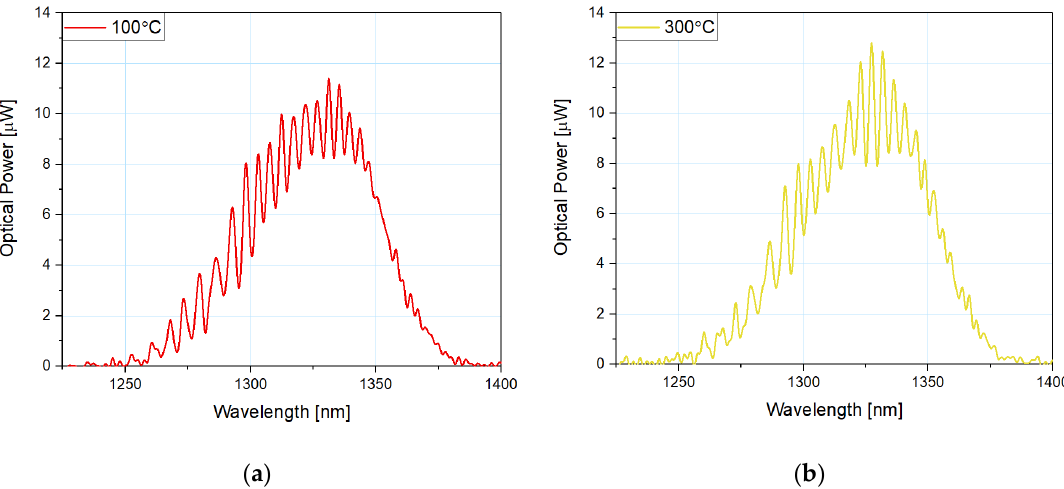
Figure 6. Measured response of the reflected signal optical power for the microsphere-based fiber-optic temperature sensor at: ( a ) 100 °C, ( b ) 300 °C. The peak optical power of the reflected signal increases when the temperature